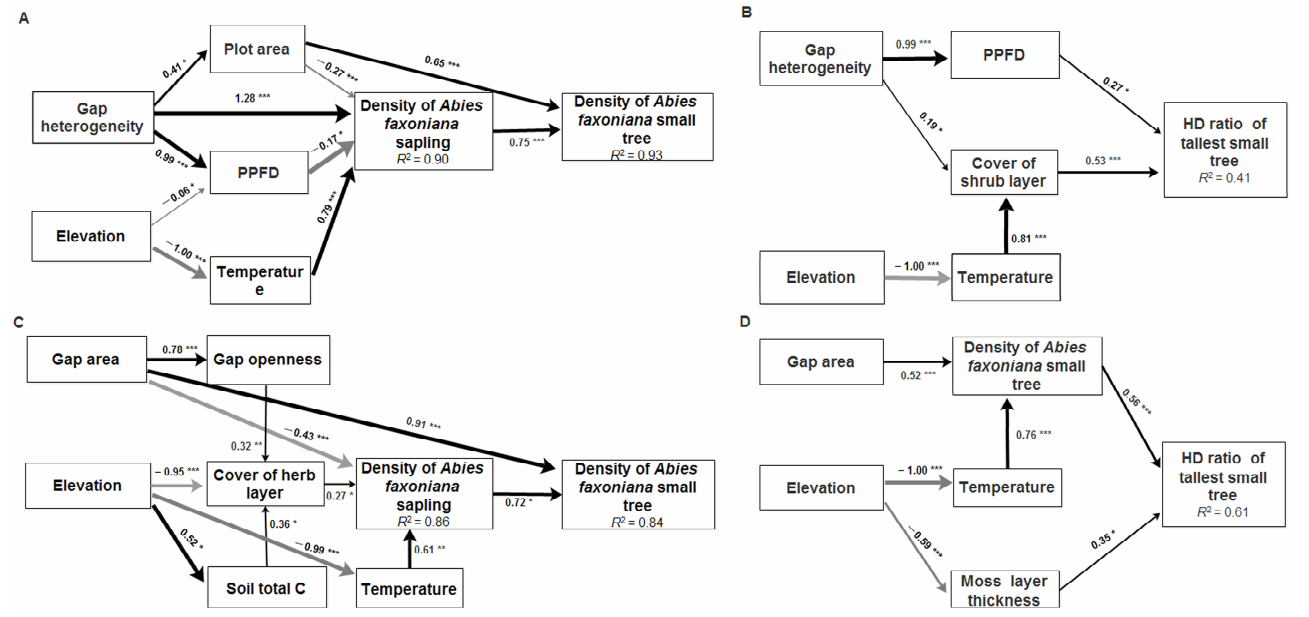
Figure 6. Best structural equation models for predicting Abies faxoniana regeneration. Four models are presented, (A): how gap heterogeneity and elevation shaped density of Abies faxoniana saplings and density of Abies faxoniana small trees; (B): how gap heterogeneity and elevation shaped the HD ratio of the tallest Abies faxoniana small trees; (C): how gap area and elevation shaped density of Abies faxoniana saplings and density of Abies faxoniana small trees; (D): how gap area and elevation shaped the HD ratio of the tallest Abies faxoniana small trees.The variables of Abies faxoniana regeneration in boxes are their variances explained by the model. All path coefficients represent standardized partial regression coefficients. Error variables are not shown in this figure. The exogenous variable of gap heterogeneity is coded as forest gap = 1 and forest = 0. The endogenous variables, as predicted variables, are the plot area (the area of gap and CK) (m 2 ), gap area (m 2 ), gap openness, cover of shrub layer (%), cover of herb layer (%), moss layer thickness (cm), PPFD (μmol m −2 s −1 ), temperature (°C), soli total C (%), density of Abies faxoniana saplings (N m −2 ), density of Abies faxoniana small trees (N m −2 ), and the HD ratio of tallest Abies faxoniana small trees. The shaded arrows represent the negative effect and the black arrows represented the positive effect. The thickness of the arrows indicates the magnitude of correlation between variables and significant coefficients are indicated by asterisk (* p < 0.05, ** p < 0.01, *** p < 0.001).